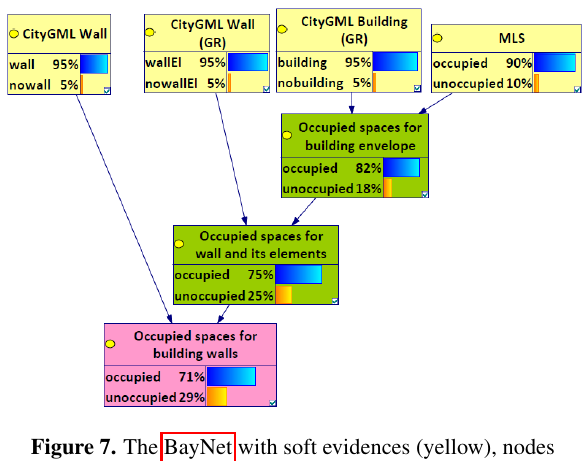
Figure 7. The BayNet with soft evidences (yellow), nodes (green), and target node (pink) and associated inference posterior probability distribution (PPD) scores. GR stands for generalized range of city model with associated